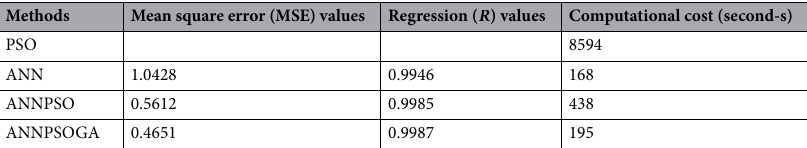
Table 5. Obtained results of methods.